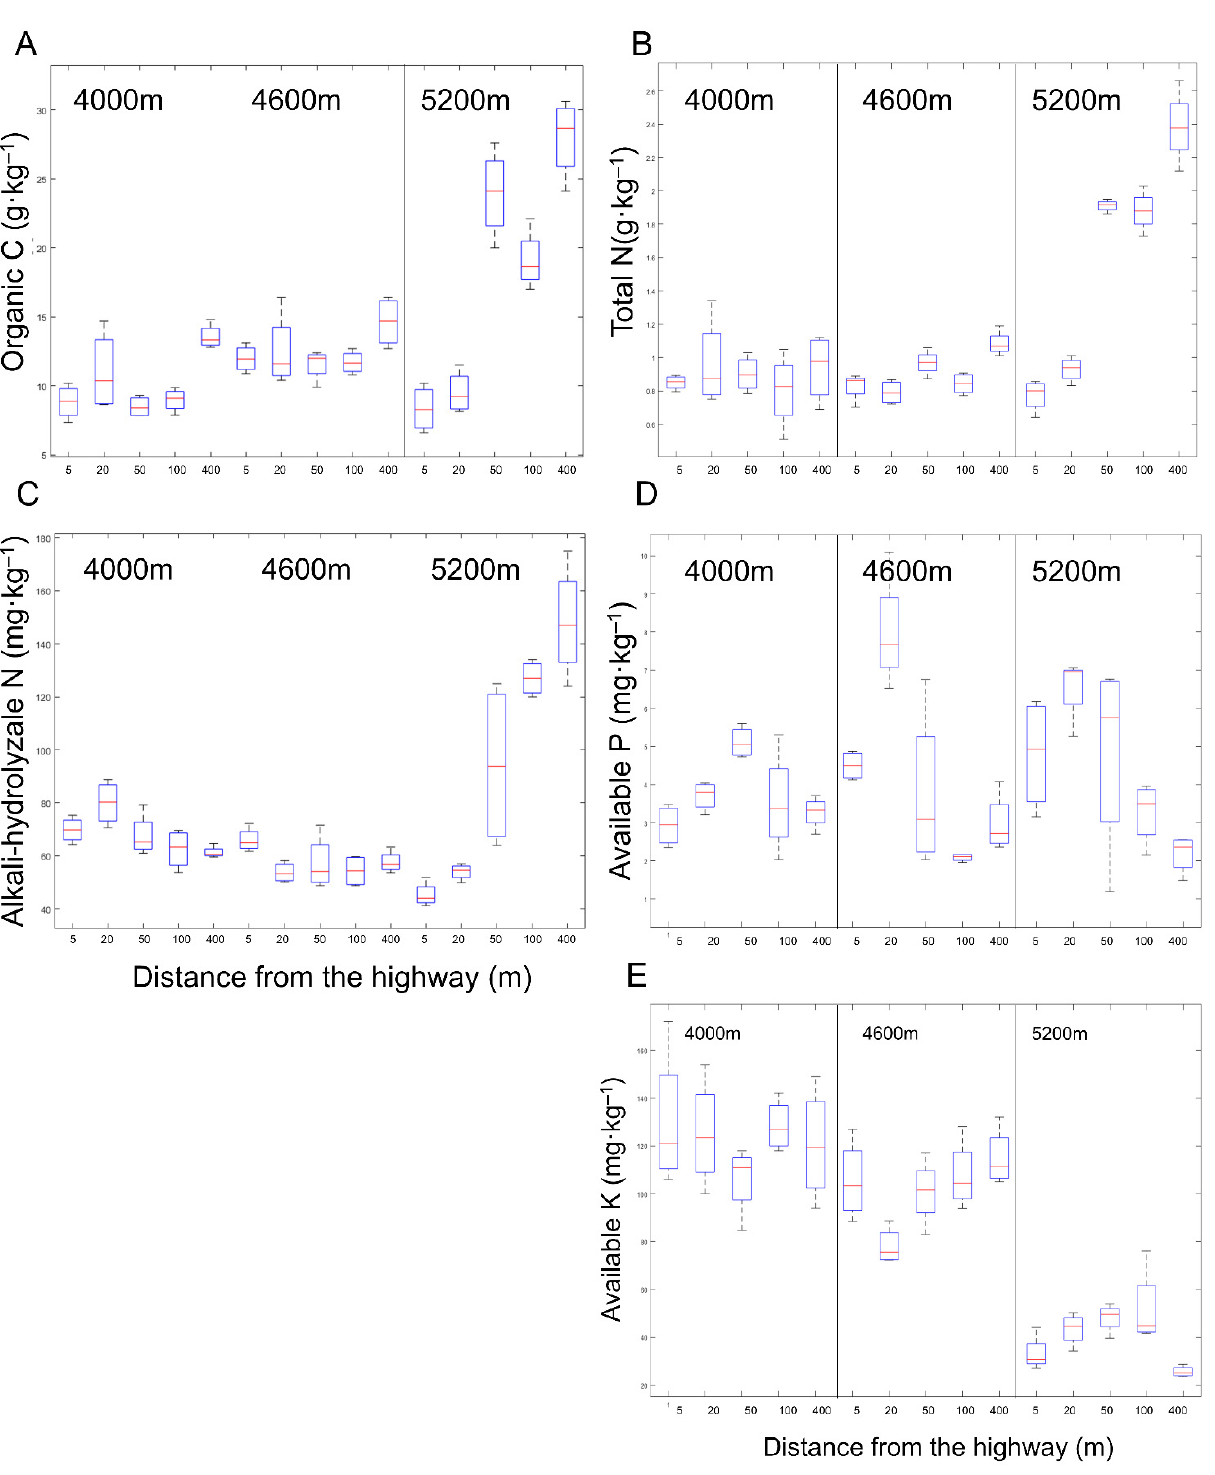
Figure 4. Comparison of soil: ( A ) organic carbon (SOC), ( B ) total nitrogen (TN), ( C ) alkali-hydrolyzable nitrogen (AN), ( D ) available phosphorus (AP), and ( E ) available potassium (AK) between treatments at 5, 20, 50, 100, and 400 m from the curb G109 highways at altitudes of 4000 m (L), 4600 m (M), and 5200 m (H).